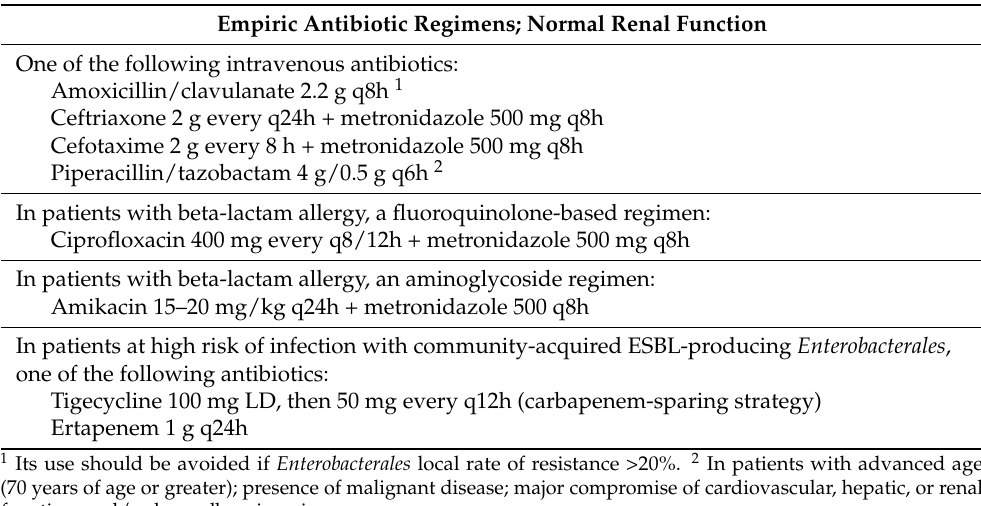
Table 1. Patients with community-acquired intra-abdominal infection without sepsis or septic shock. Empiric Antibiotic Regimens; Normal Renal Function